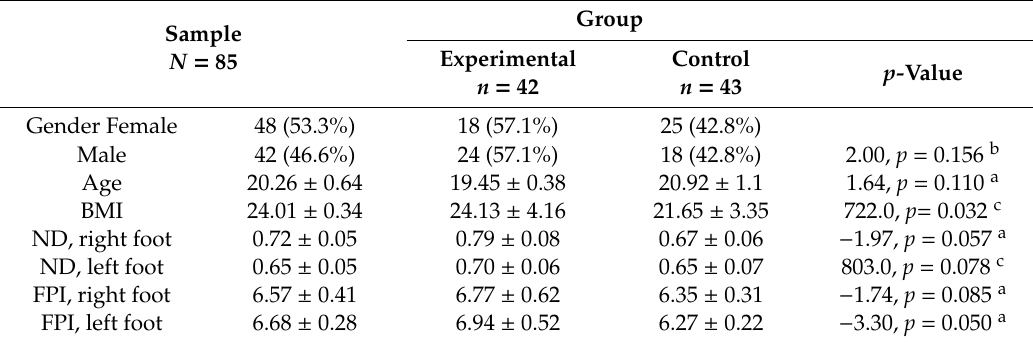
Table 1. Initial values of the demographic variables of the whole sample and for both groups as well as the navicular drop (ND) and Foot Posture Index (FPI) variables for right and left feet (average ± standard deviation).